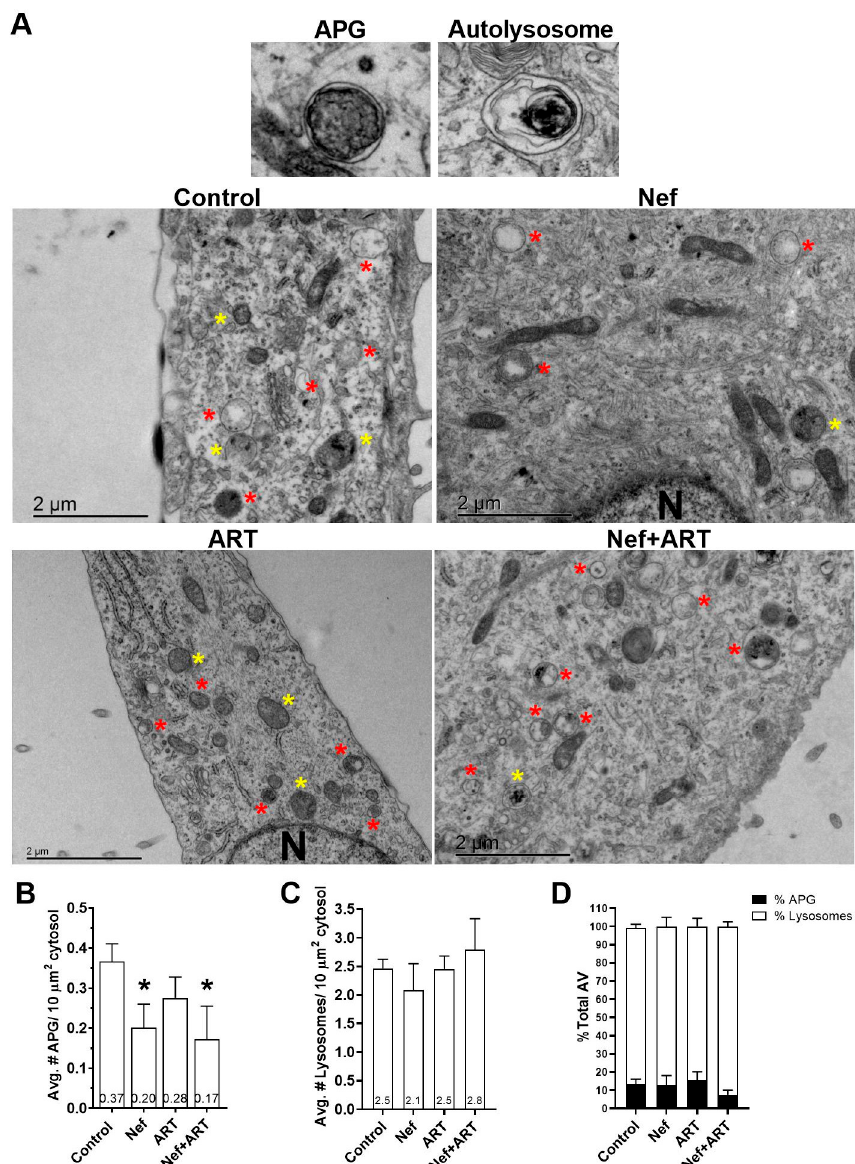
Figure 3. Ultrastructural analysis of APG and lysosomes after treatment with Nef and / or ART. Primary human astrocytes were treated with extracellular Nef and / or ART for 24 h and prepared for and analyzed by transmission electron microscopy as described in Methods. ( A ) Representative APG and autolysosome, and images of control, Nef, ART, and Nef + ART treated cells. Yellow stars = APG; red stars = Lysosomes; N = nucleus. ( B ) The mean number of APG per 10 µ m 2 cytosol. ( C ) The mean number of lysosomes per 10 µ m 2 cytosol. ( D ) Mean percent APG and lysosomes of total AV in control, Nef, ART, and Nef + ART treated astrocytes. Error bars represent SEM. n = 2 independent experiments, with a total of 23–27 cells per condition analyzed. *, p < 0.05 by Mann-Whitney test.